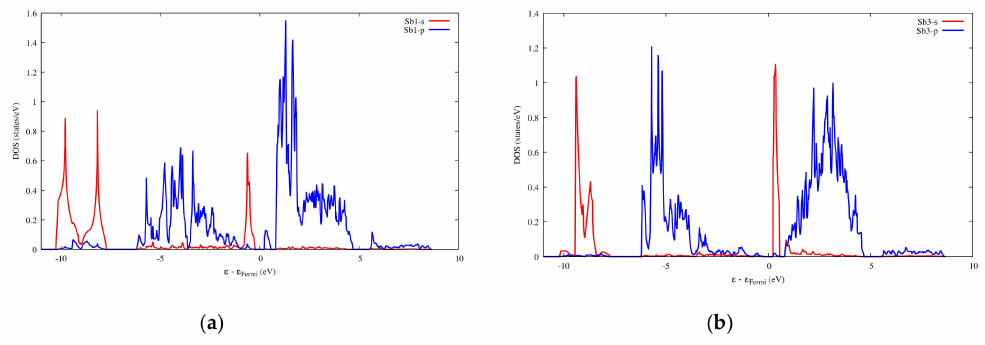
Figure 15. Projected DOS of SbS 2 Ga 2 . ( a ) On the Sb1 atoms; ( b ) On the Sb3